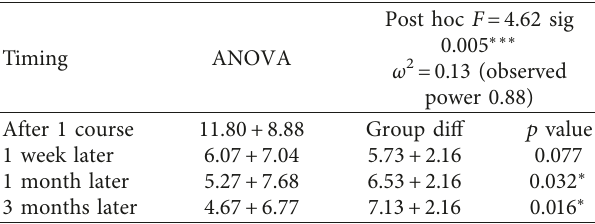
Table 3: PEG score differences: ANOVA and Scheffe’s post hoc